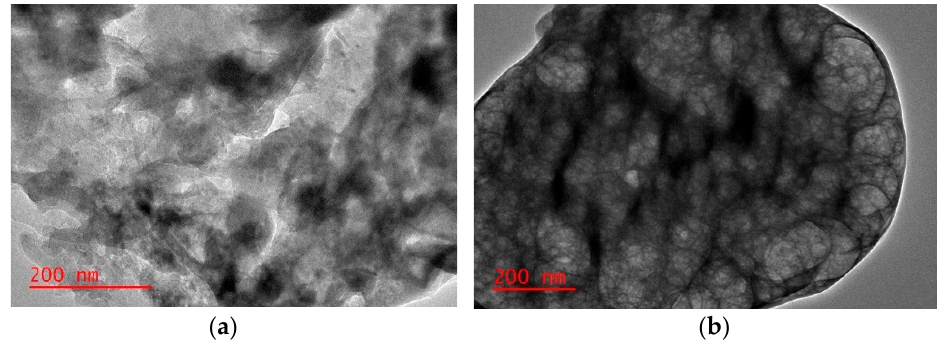
Figure 6. TEM images of: ( a ) SCB and ( b ) OPS.